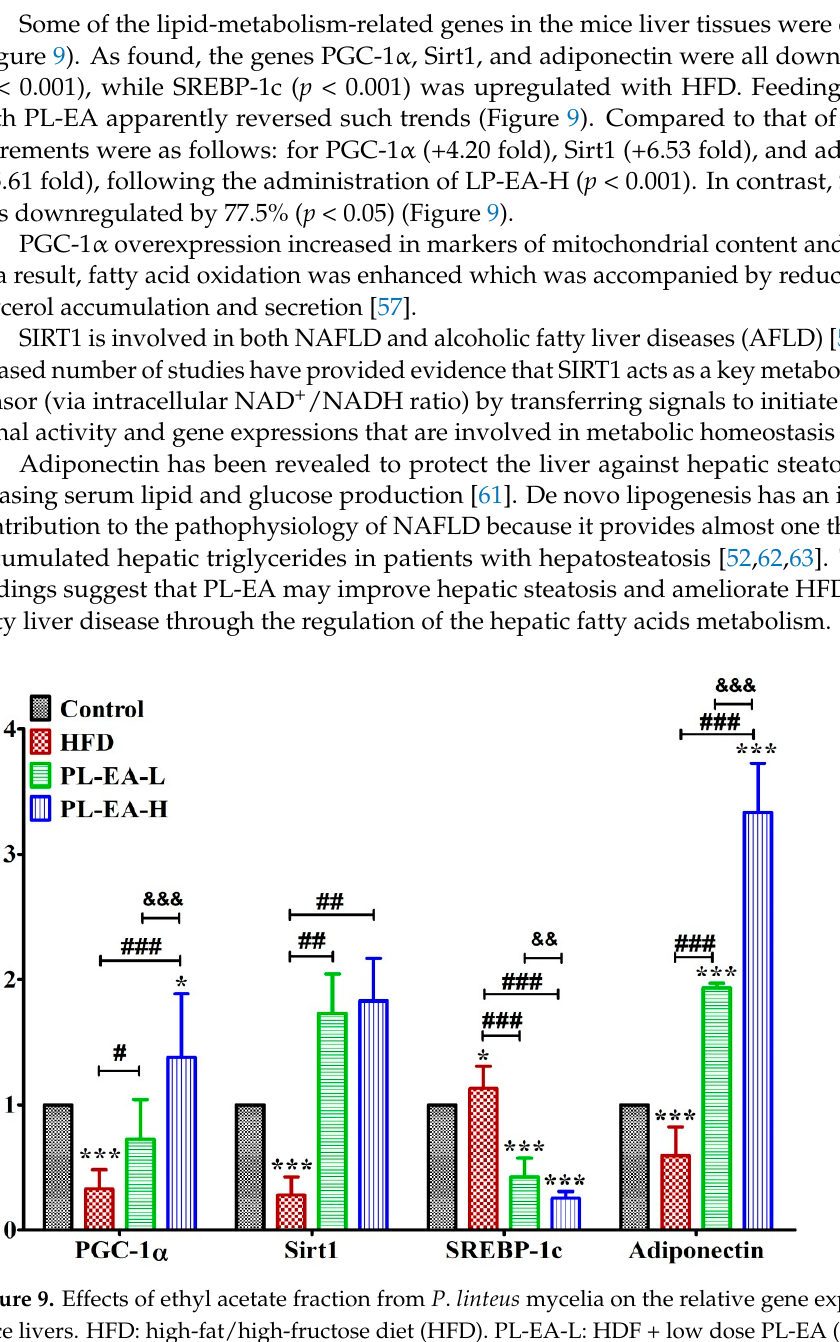
Figure 8. Effects of purified compounds from PL-EA on Oil Red O staining and lipid. accumulation in HepG2 cells. Lipid droplets in HepG2 cells were photographed by phase contrast microscopy (original magnification ×200) ( A ). The lipid content from Oil Red O stained cells was quantified by spectrophotometric analysis at 500 nm ( B ). Bars represent mean ± SE ( n = 3) *** p < 0.001 vs. the control ; ### p < 0.001 vs. the O/P group; &&& p < 0.001. Significant differences between groups were determined using one-way ANOVA followed by Tukey’s procedure.